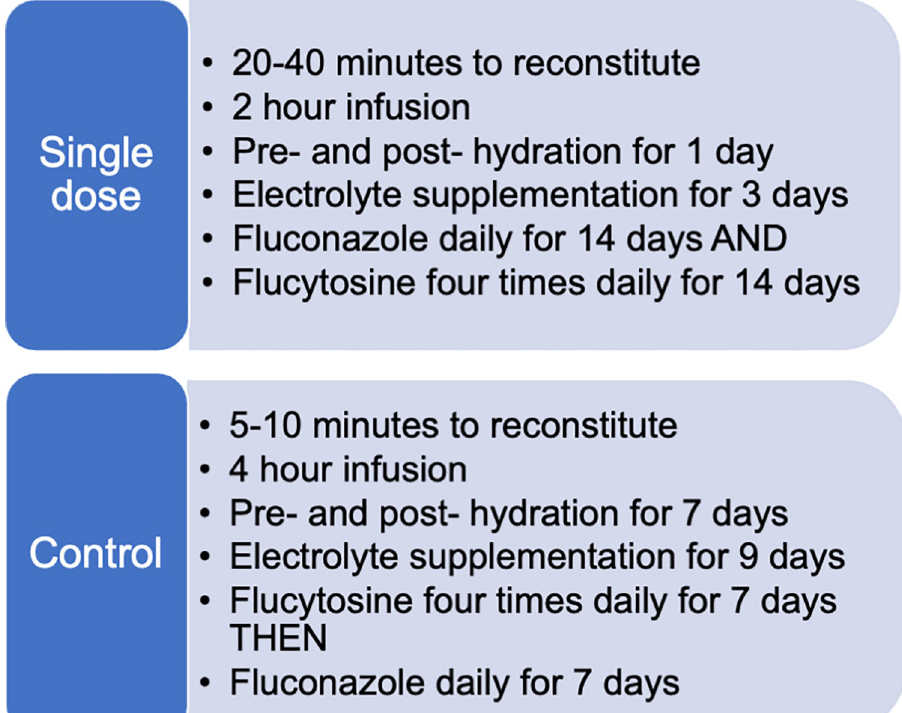
Fig 1. A summary of how each of the two treatment regimens were